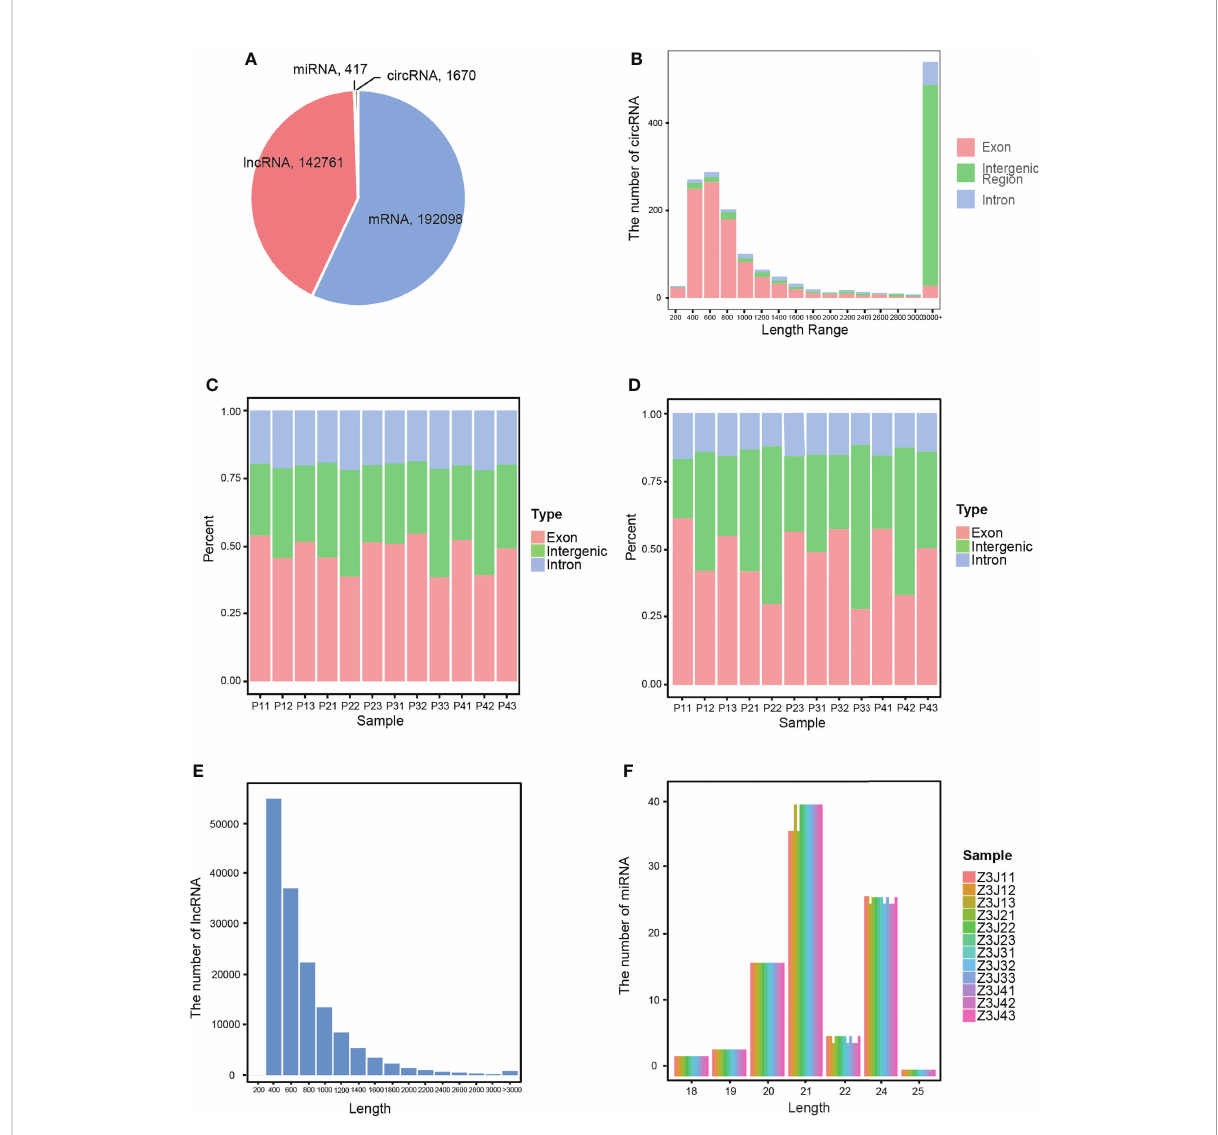
FIGURE 1 Characterization of RNAs. (A) The number of each type of RNA in all samples. (B) The length distribution of circRNAs. (C) The type and percentage of circRNAs in each sample. (D) The type and percentage of lncRNAs in each sample. (E) The length distribution of lncRNAs. (F) The length distribution of miRNAs in each sample. Drought treatment with three biological repetitions each: 0 day (P11, P12, P13), 2 days of drought treatment (P21, P22, P23), 4 days of drought treatment (P31, P32, P33) and 6 days of drought treatment (P41, P42,